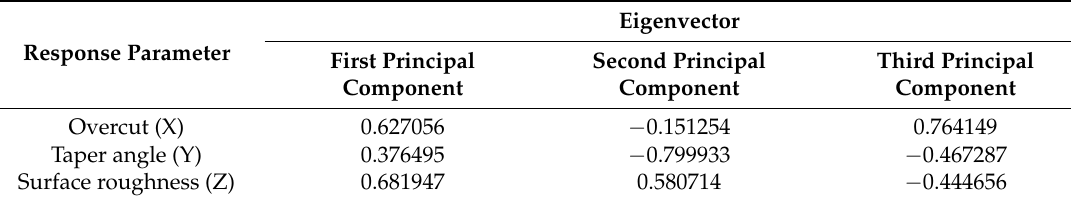
Table 8. Eigenvectors for principal components.